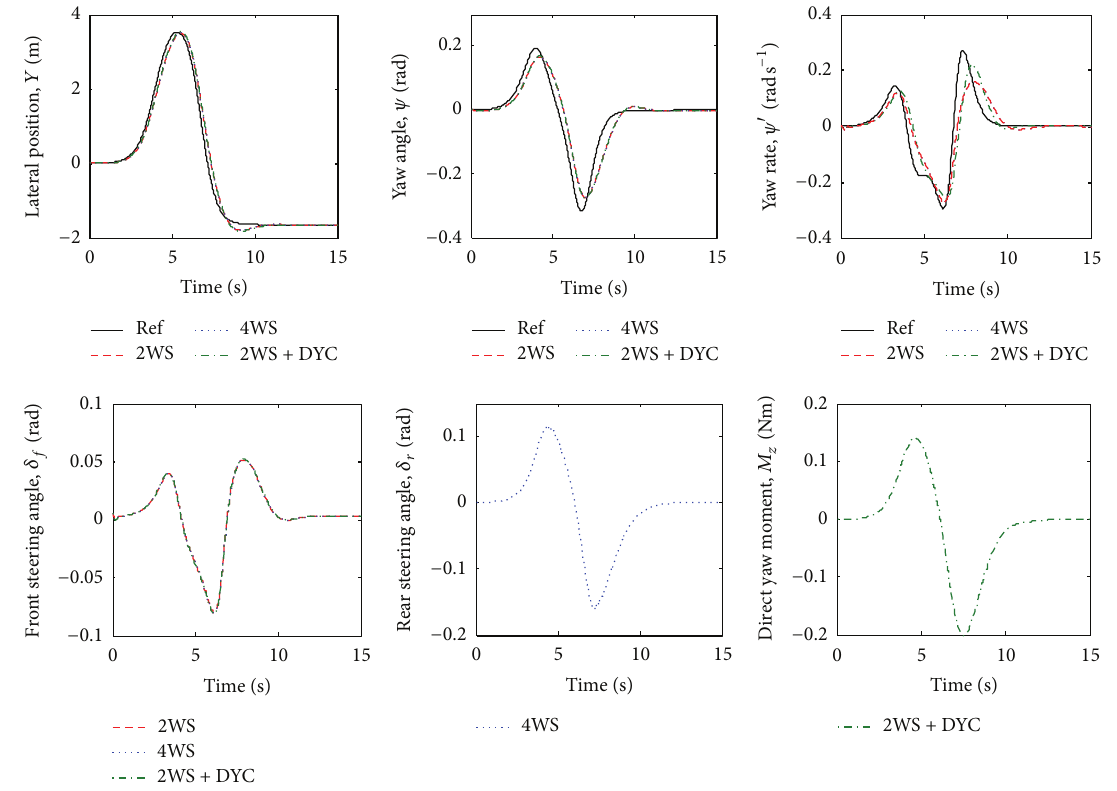
Figure 10: 2DoF controller at 10ms −1 and 𝜇 = 0.1 by 2WS, 4WS, and 2WS + DYC. Table 4: Model predictive control weighting matrices parameters for V 𝑥 = 30 ms −1